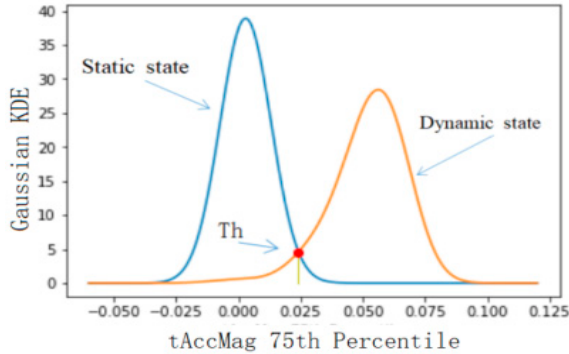
Figure 6. Probability distribution of static and dynamic action.